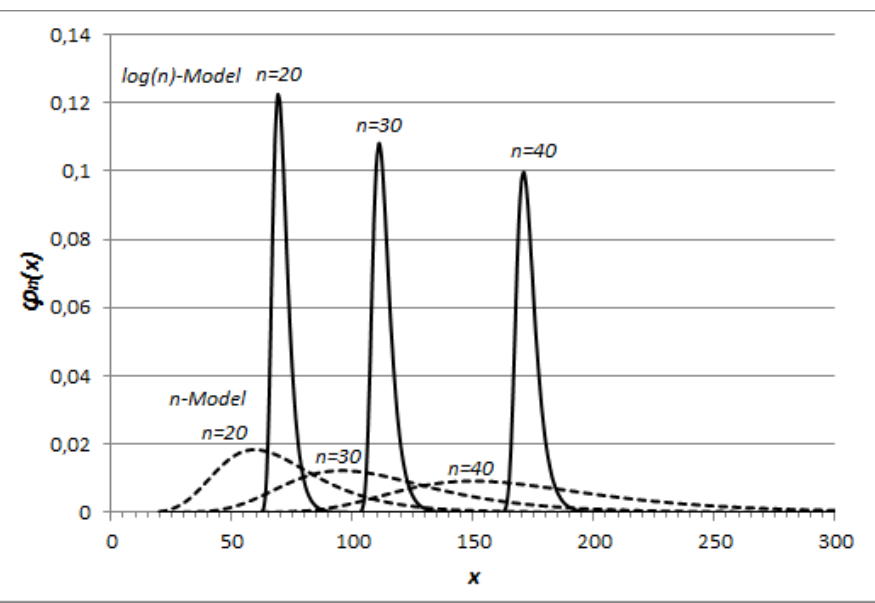
Figure 3. Heuristic model probability distribution functions φ n ( x ) for n =